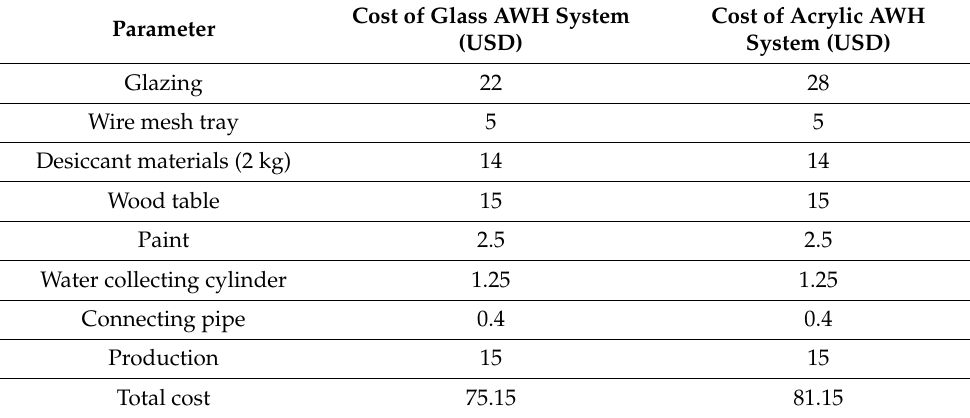
Table 5. Cost breakdown of AWH